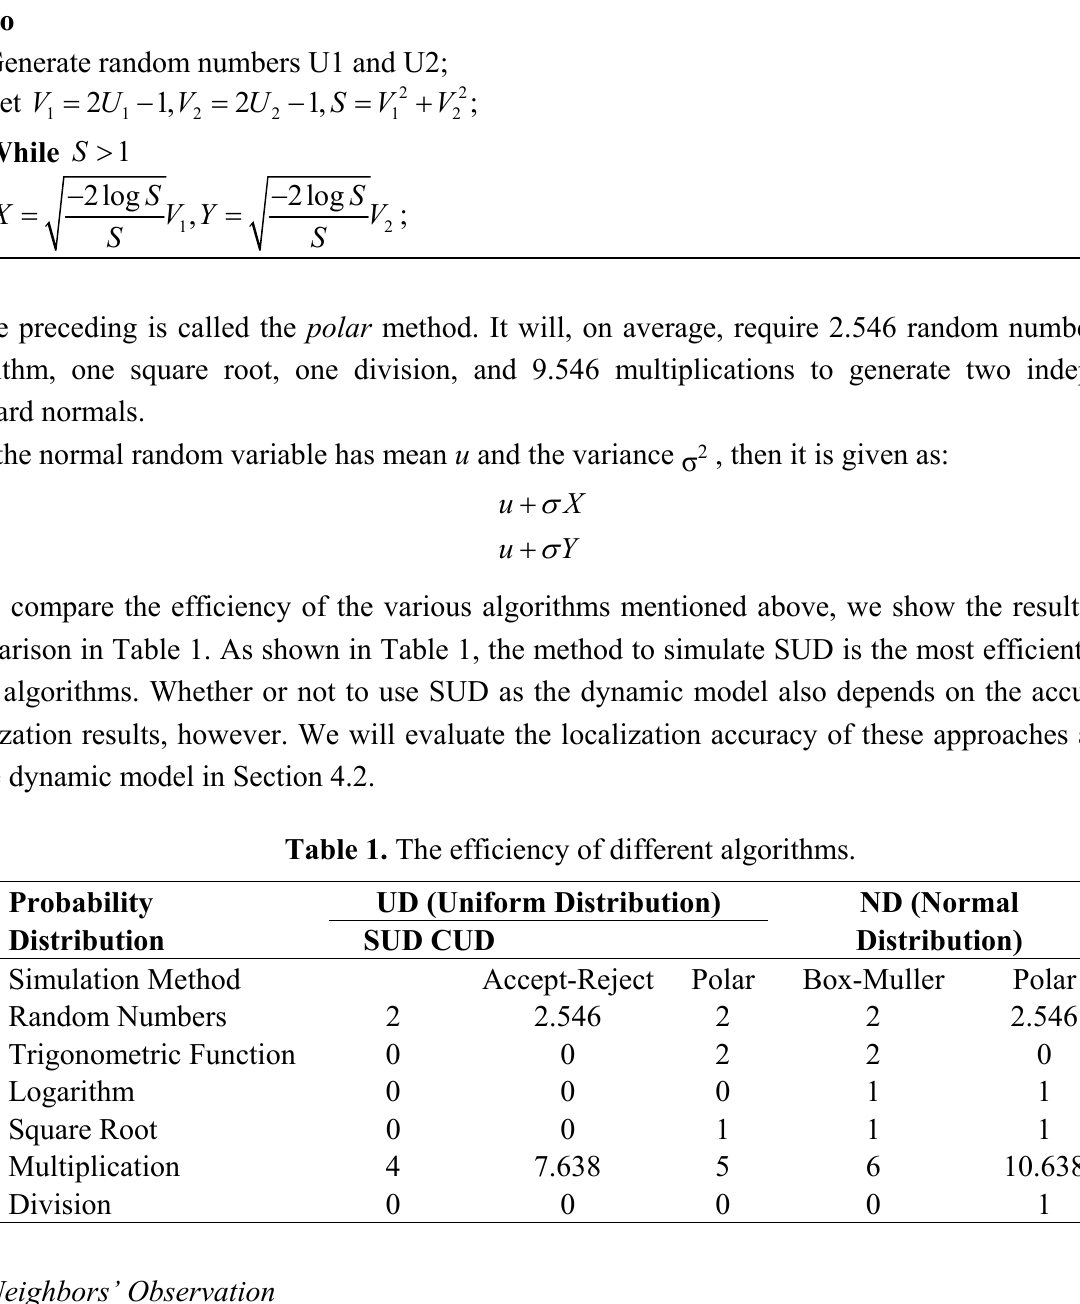
Algorithm 2. Polar method